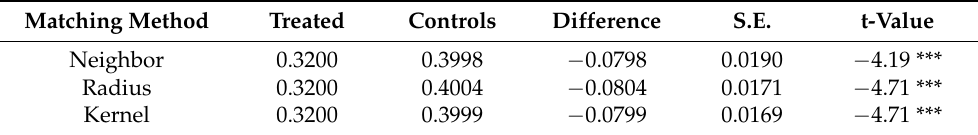
Table 7. Estimated results of average treatment